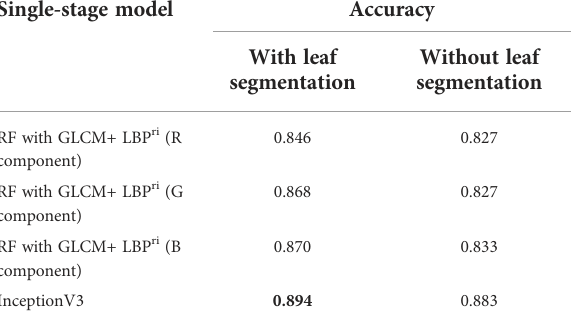
TABLE 2 Identi fi cation performances of single-stage RF models designed with different combination of texture feature acquisition methods and gray-level images (obtained from the different R, G or B component).